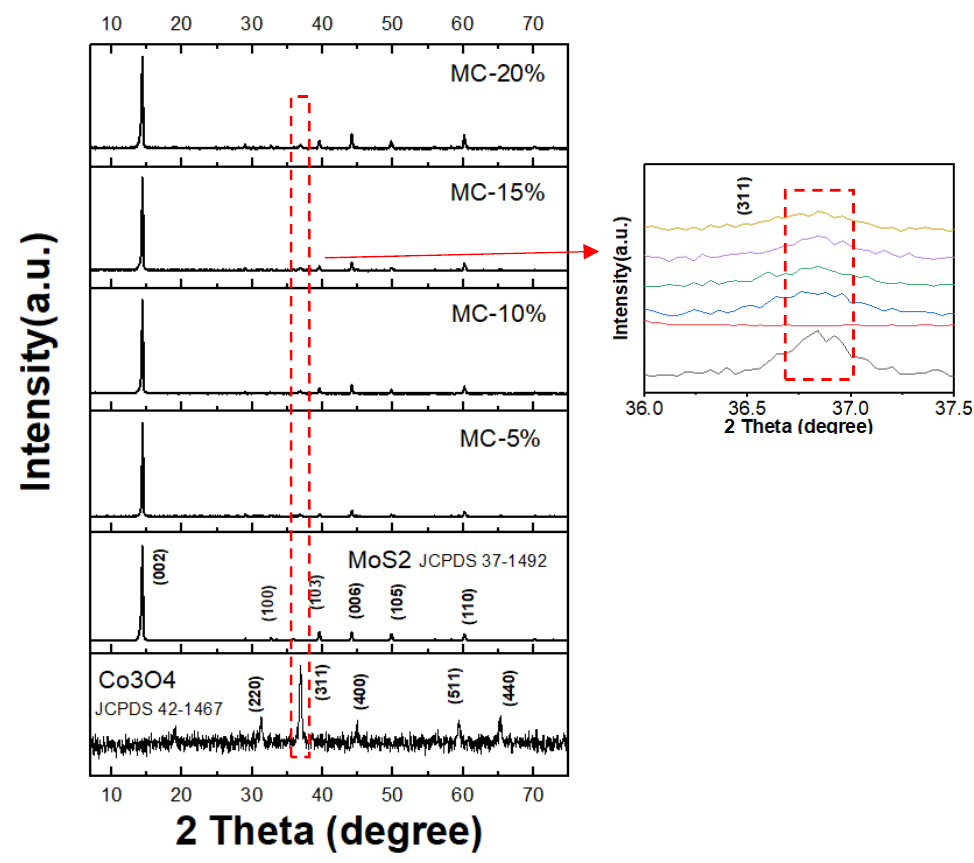
Figure 1. XRD patterns of MoS 2 , Co 3 O 4 , MC-5%, MC-10%, MC-15%, and MC-20% samples, inset shows the intensity of (311) XRD peak.